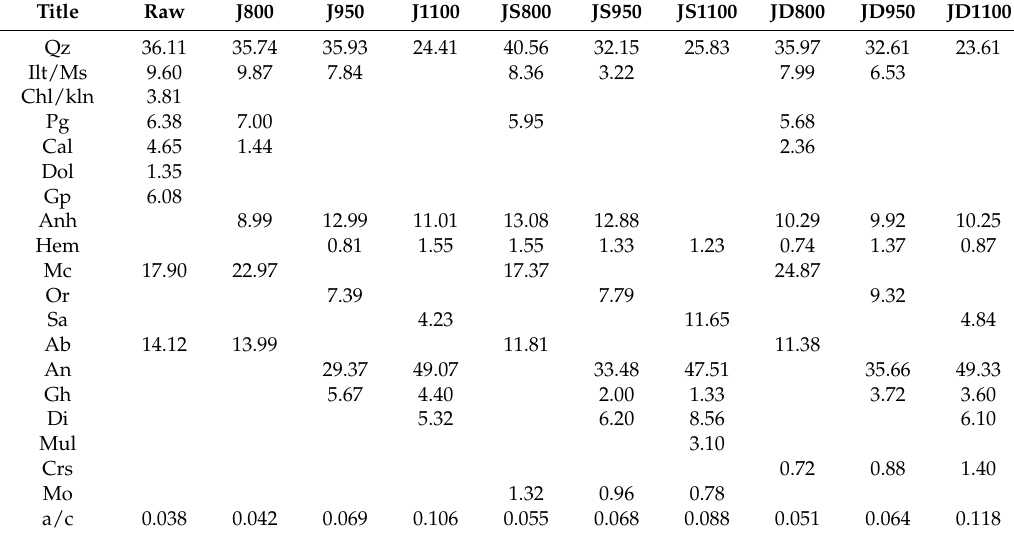
Table 2. Mineralogical composition of the raw material (raw), bricks without additives (J), and with added sodium chloride (JS) and calcined diatomite sludge (JD) fired at 800 ◦ C, 950 ◦ C, and 1100 ◦ C. Qz = quartz (789); Ilt/Ms =illite/muscovite (2013); Chl/Kln = chlorite/kaolinite (4285); Pg = paragonite (8408); Cal = calcite (98); Dol = dolomite (86); Gp = gypsum (4651); Anh = anhydrite (5117); Hem = hematite (143); Mc = microcline (5216); Or = orthoclase (313); Sa = sanidine (18062); Ab = albite (536); An = anorthite (370); Gh = gehlenite (5090); Di = diopside (1334); Mul = mullite (1059); Crs = cristobalite (10750); Mo = molysite (12857); a/c = amorphous/crystal relationship. AMCSD codes are indicated in brackets after each mineral name. Mineral abbreviations after Whitney and Evans